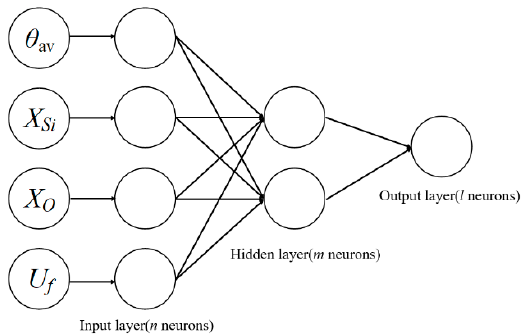
Figure 7. Structure of back propagation (BP) neural network.